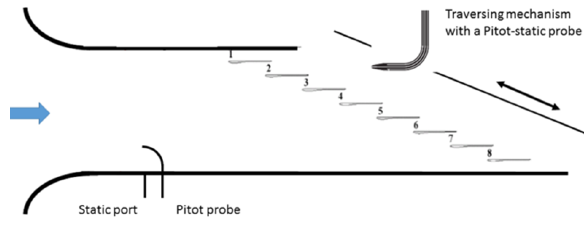
Figure 2. Schematic of the test section part, top view.